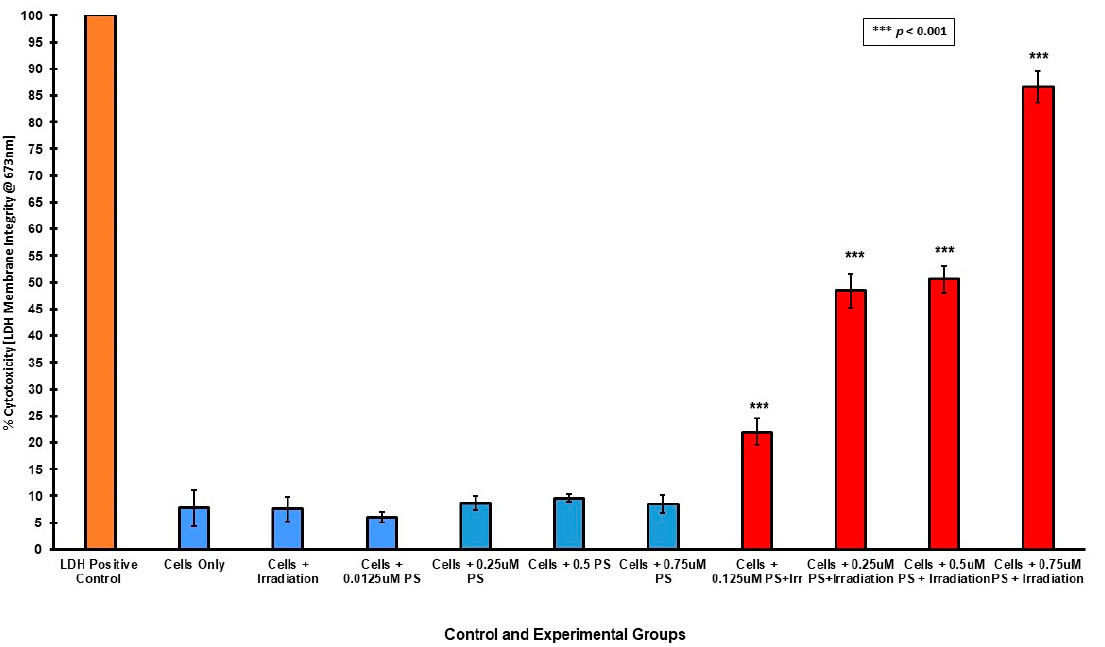
Figure 9. Cytotoxicity measured by an LDH membrane integrity assay. AlClPcTS41 PS only at 0.0125, 0.25, 0.5, and 0.75 µM were insignificant when compared to experimental treated groups. Cells exposed to laser light and PS (treated group) resulted in a dose-dependent increase in cytotoxicity compared to control groups. Results represent the mean of n = 3 independent duplicate run-on experiments, (*** p < 0.001) shows statistical significance compared to cells only. 2.4. Cellular Localization of AlClPcTS41 and AlClPcTS41-PEG-CuAuNPs Nanoconjugates The intracellular localization of AlClPcTS41 and AlClPcTS41-PEG-CuAuNPs was studied by using fluorescence microscopy. PEG-CuAuNPs demonstrated no phototoxi- city; hence, its intracellular localization was not studied. Figure 10 shows the blue fluores- cence emanated from DAPI, which stained the cell nucleus, and two intracellular orga- nelles (lysosome and mitochondria) were stained with organelle-specific fluorescent tracker dyes. Figure 10 also shows that the MitoTracker and LysoTracker dyes were stained green, and the AlClPcTS41 was marked in red fluorescence, to indicate the PS localization in different intracellular organelles. The localization of AlClPcTS41 (red fluo- rescence) in lysosome and mitochondria displayed a yellow fluorescence in the merged images, as illustrated in Figure 10. Comparisons between the AlClPcTS41 distribution evinced that the ALClPcTS41 most likely localized in both the mitochondria and lyso- somes and it turned out that the AlClPcTS41-PEG-CuAuNPs appeared to have accumu- lated more in both the intracellular organelles.